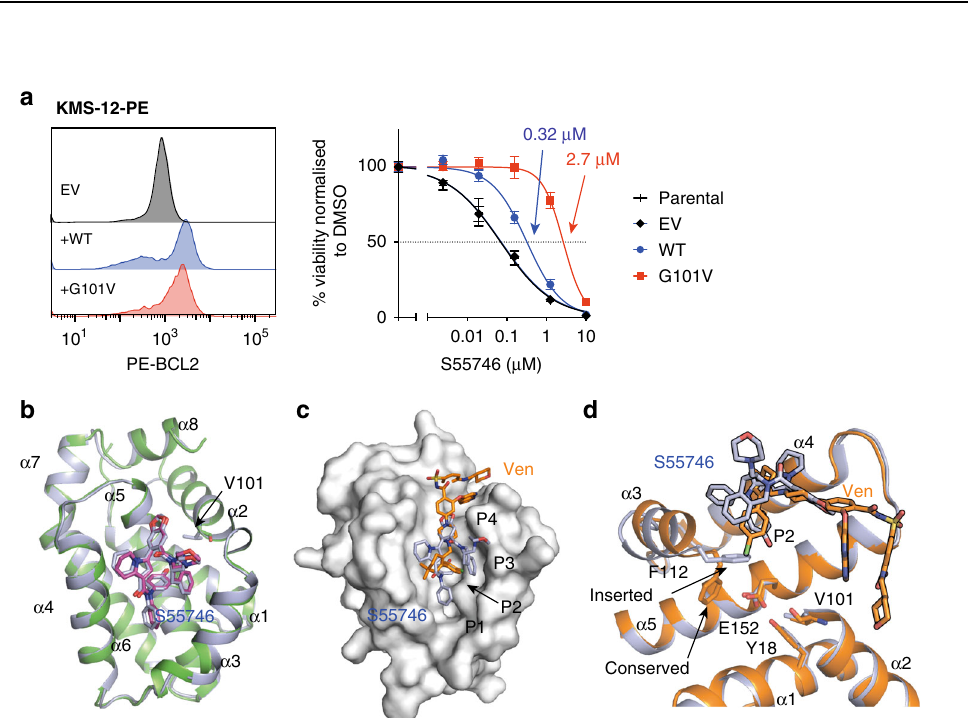
Fig. 4 BCL-2 G101V binding to S55746. a Expression of BCL-2 G101V mutant reduces S55746 sensitivity in the KMS-12-PE B-lineage cell line. WT and G101V mutant BCL-2 proteins were expressed at similar levels in KMS-12-PE cells as demonstrated by the FACS pro fi les. In vitro sensitivity to S55746 (0 – 10 μ M) was measured after 24 h by a CellTiter-Glo assay. Data are representative of n = 3 independent experiments with mean LC50 values ± SD (1 Standard Deviation) for empty vehicle (EV, black), WT (blue) and G101V (red) indicated. b Overlay of the published BCL-2:S55746 structure (green